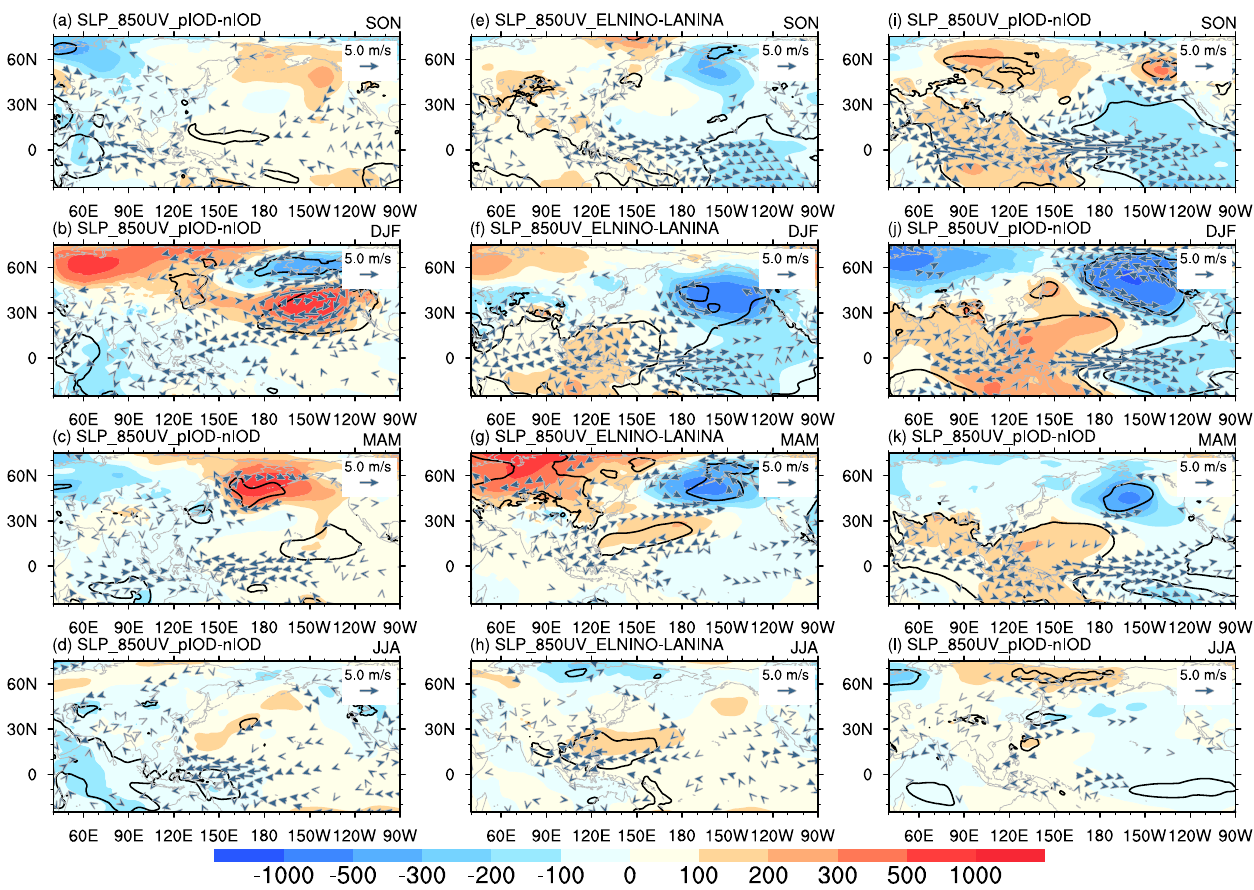
Fig. 4 Seasonal evolution of atmospheric patterns in association with IOD and ENSO. Composite seasonal evolution of horizontal winds (vectors) at 850 hPa and sea surface pressure (shading, Pa) from autumn to the ensuing summer based on the years when a – d only IOD occurs, e – h only El Niño occurs, and i – l IOD and ENSO occur together. Vectors indicate winds that exceed the 95% con fi dence level. Thick black contours denote sea surface pressure exceeding the 95% con fi dence